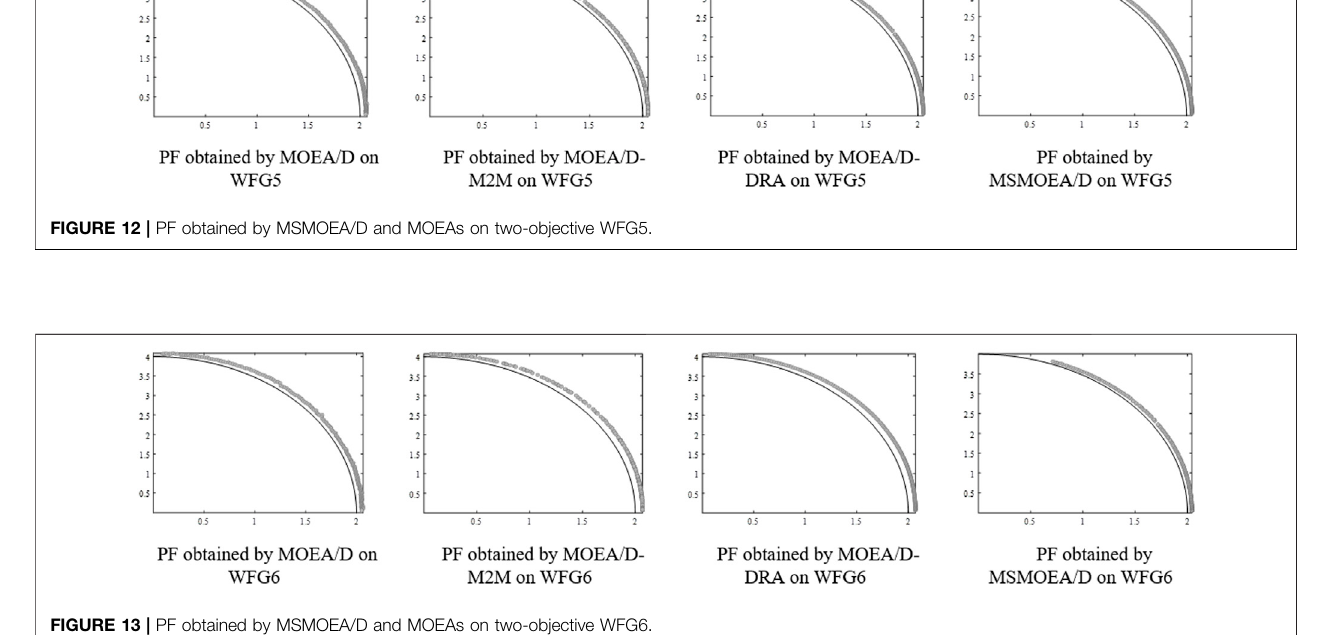
FIGURE 13 | PF obtained by MSMOEA/D and MOEAs on two-objective WFG6.